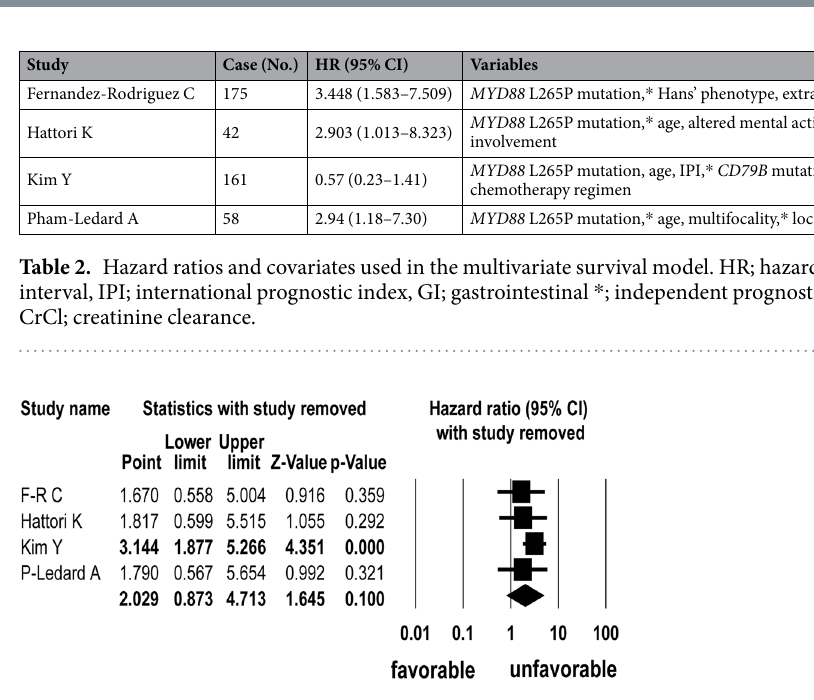
Figure 3. Sensitivity analysis of meta-analysis for the association between MYD88 L265P mutation and survival